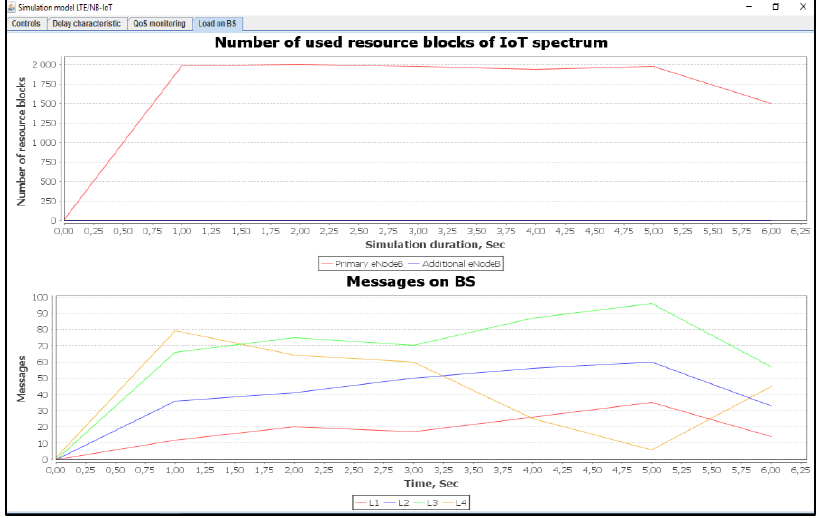
Figure 18. Used IoT spectrum resource blocks and transmitted messages ratio with different priorities (average load of IoT controller ρ = 50%).